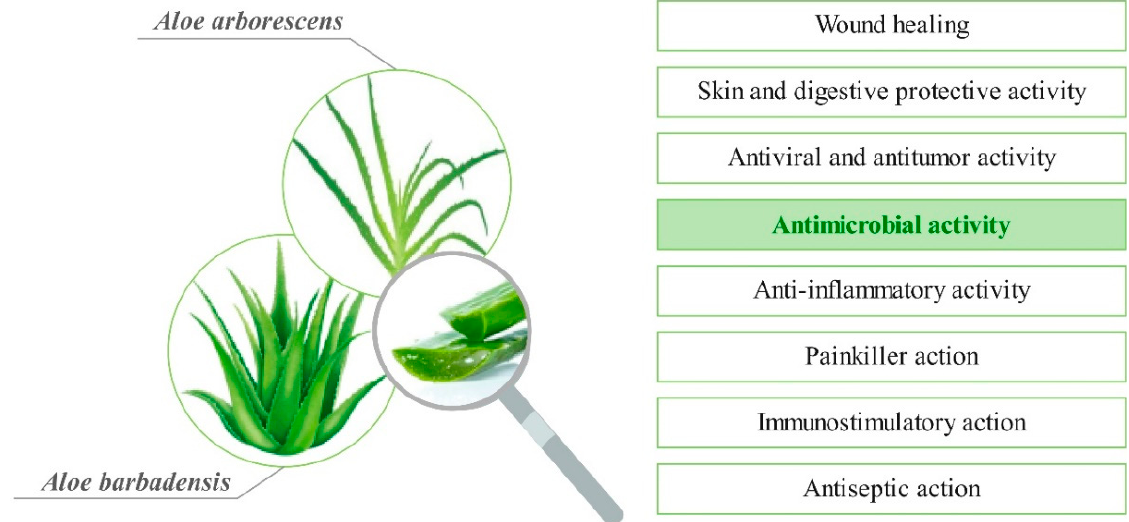
Figure 1. Medical benefits of A. arborescens and A. barbadensis [10–15].